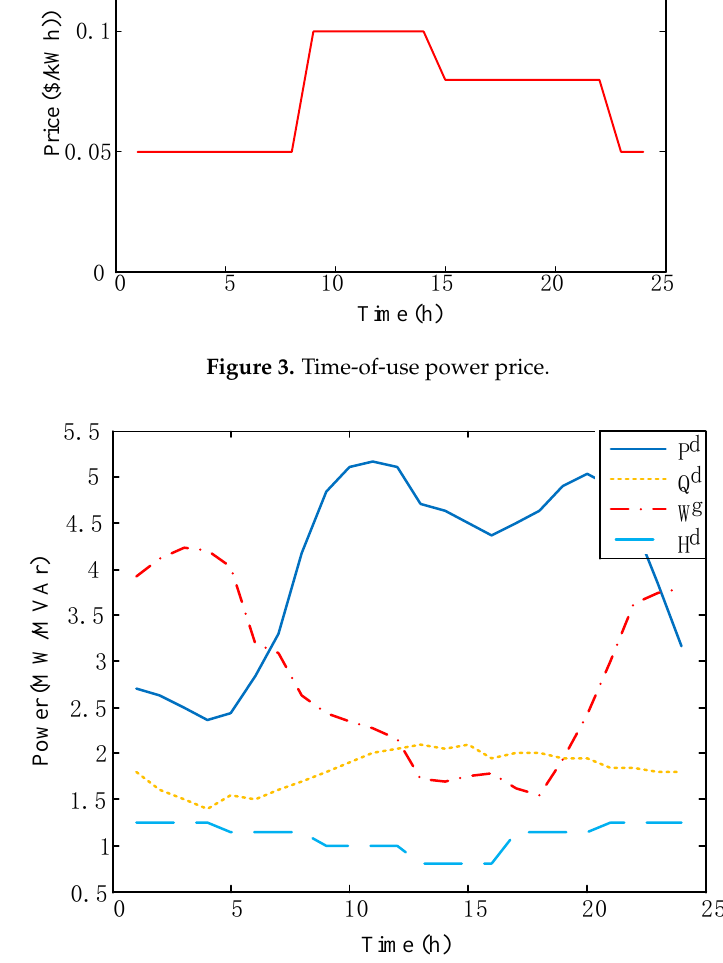
Figure 4. The forecasted power load, heat demand, and predicted wind power